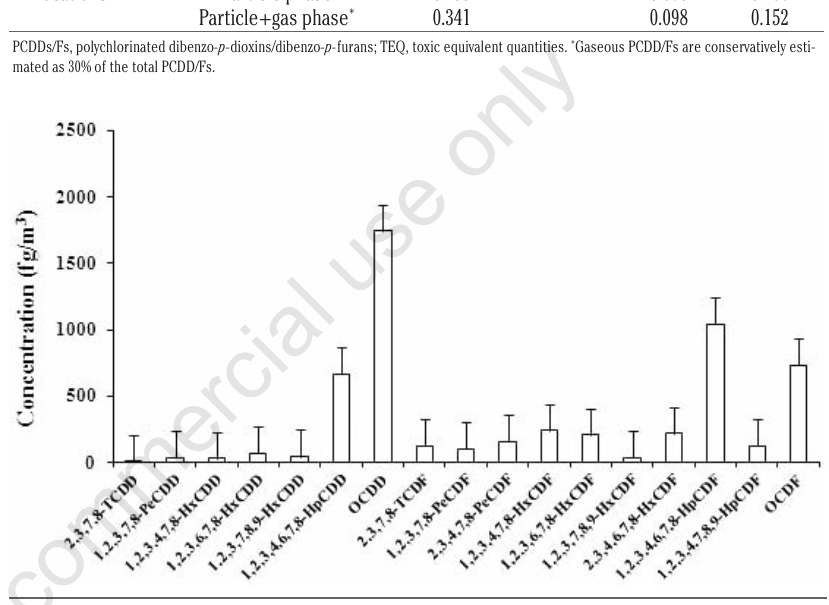
Figure 1. Concentration profiles of polychlorinated dibenzo -p- dioxin/dibenzo -p- furans congener in ambient air (PM ) in Delhi. 10